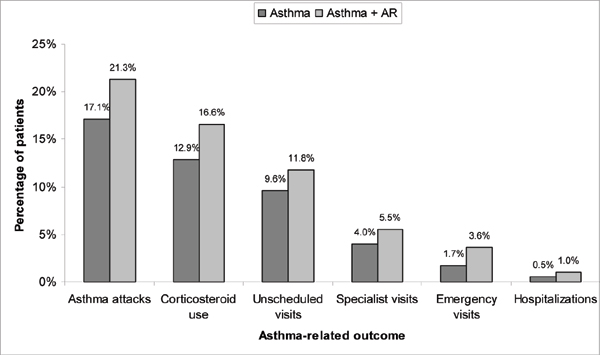
Asthma-related resource use and asthma attacks according to the presence of concomitant allergic rhinitis. In a post-hoc analysis of the Investigation of Montelukast as a Partner Agent for Complementary Therapy trial, rates of asthma attacks and emergency room visits were significantly higher among patients with comorbid asthma and allergic rhinitis (AR). Adapted with permission from Bousquet and coworkers [34].